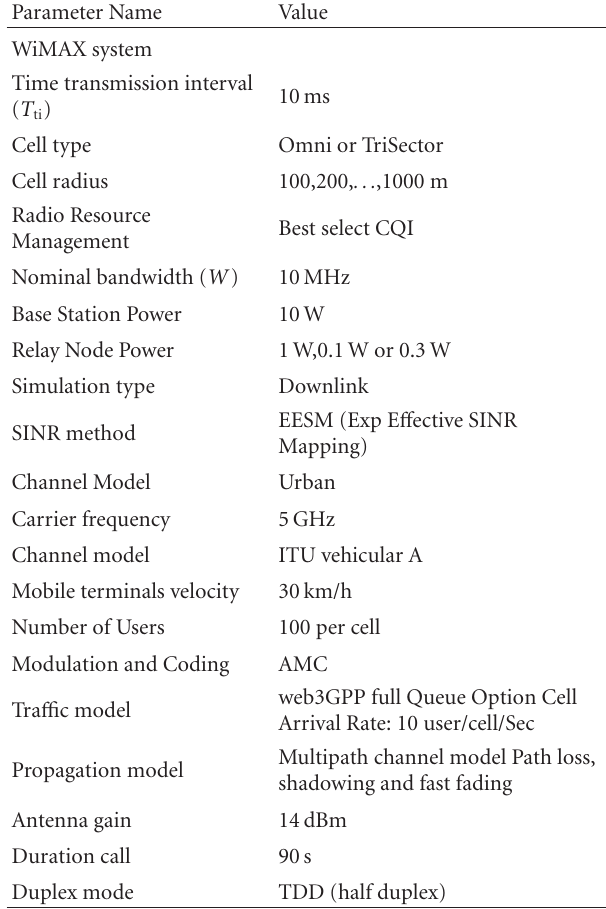
Table 5: Simulation